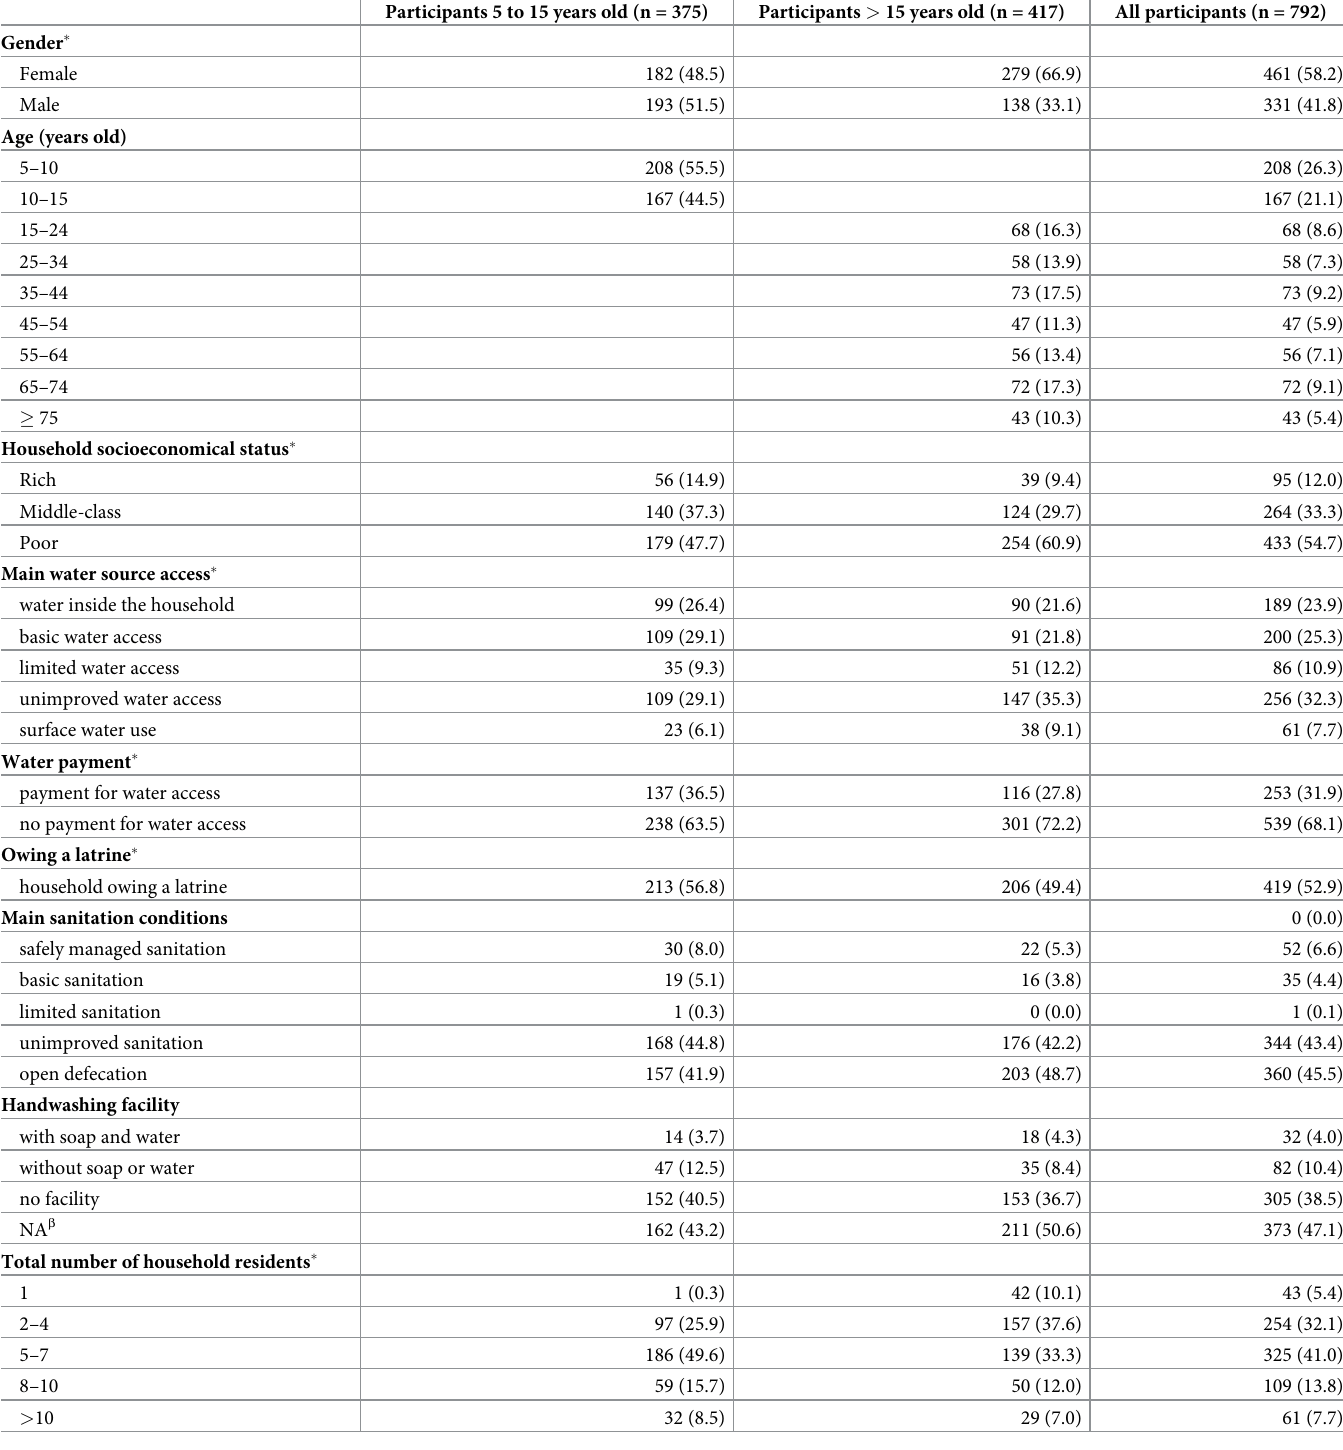
Table 1. Description of study participants’ characteristics by frequency and percentage, n (%). Water and sanitation are defined according UNICEF Joint Monitoring Programme